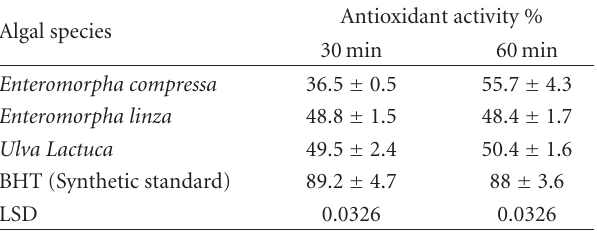
Table 2: Antioxidant activity of crude ethanolic extract of three green macroalgal species against DPPH radical scavenging